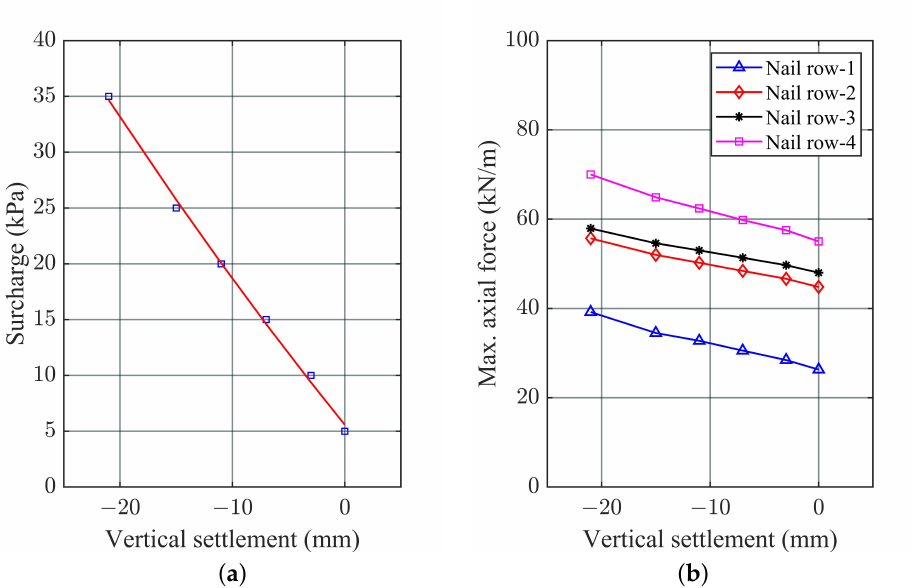
Figure 13. Relation between: ( a ) surcharge; ( b ) maximum nail tensile force, with ground surface vertical